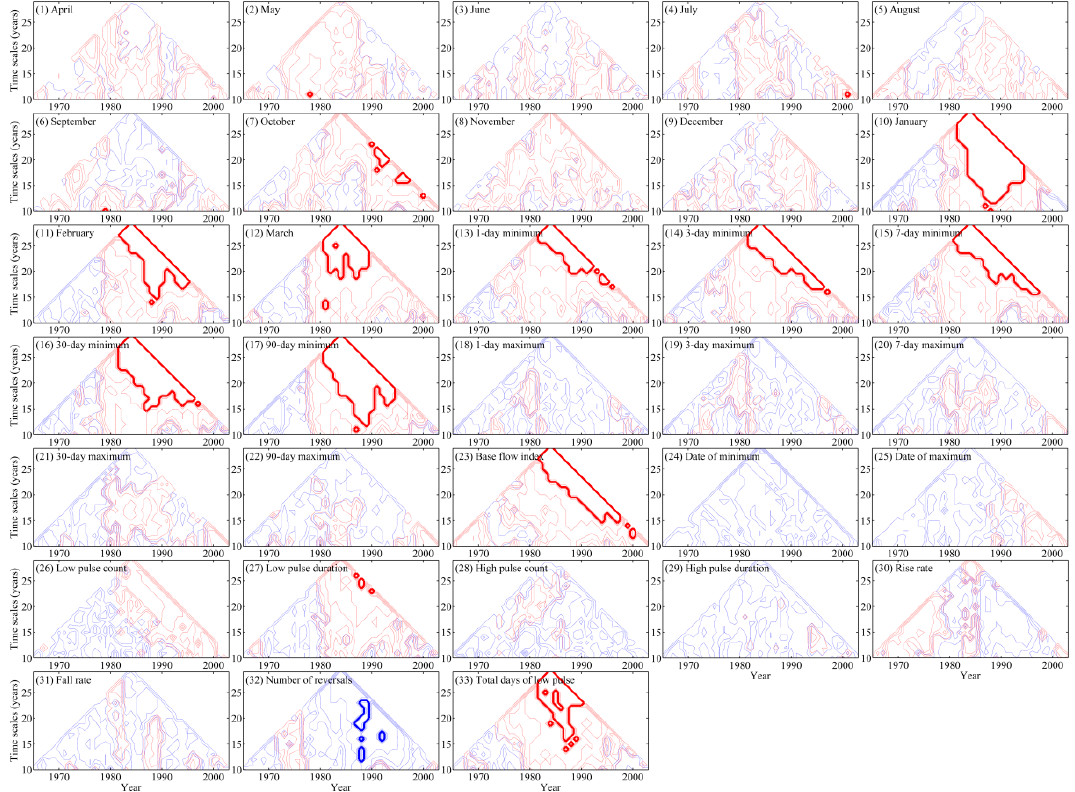
Figure 15. Coherency between hydrologic regimes of the four stations.